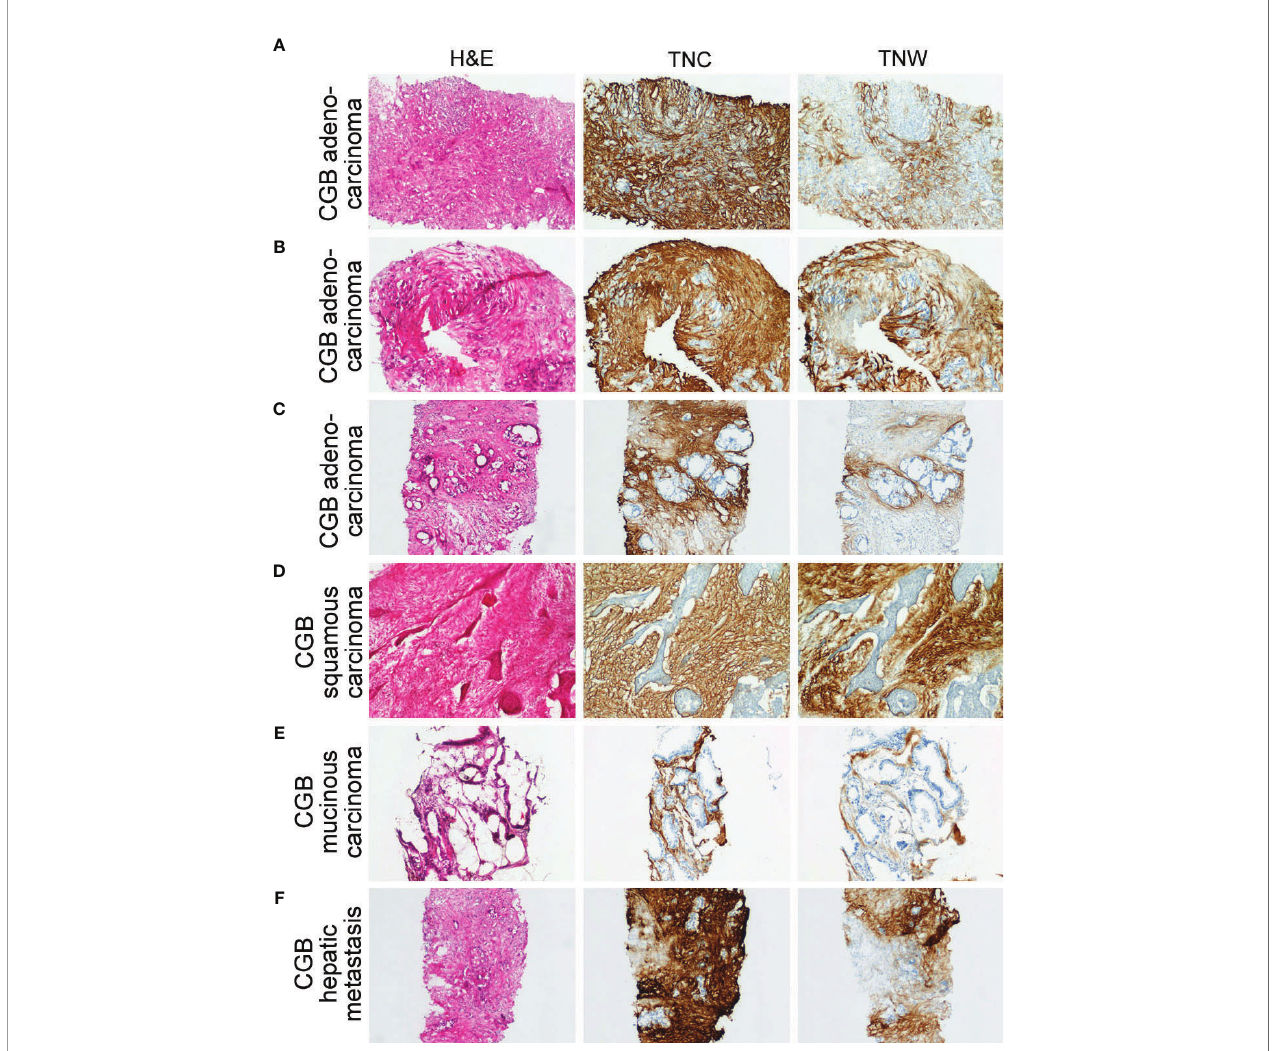
FIGURE 3 | Sections through needle biopsies of carcinomas of the gallbladder and a hepatic metastasis from a carcinoma of the gallbladder stained with hematoxylin or immunostained with anti-tenascin-C (TNC) or anti-tenascin-W (TNW). (A – E) Immunostaining of carcinomas of the gallbladder (CGB). The stroma of a poorly differentiated adenocarcinoma (Patient ID 18; A ), a moderately differentiated adenocarcinoma (Patient ID 17; B ) and a well differentiated adenocarcinoma (Patient ID 26; C ) are immunolabeled with both TNC and TNW (100X). Both TNC and TNW label the stroma of a squamous carcinoma (Patient ID 19; D ; 100X) and a mucinous carcinoma (Patient ID 22; E ; 100X). (F) A representative section through a needle biopsy of a hepatic metastasis from a carcinoma of the gallbladder (Patient ID 27) shows strong TNC and TNW immunolabeling in the tumor stroma (100X). A third section in each series was stained with hematoxylin and eosin